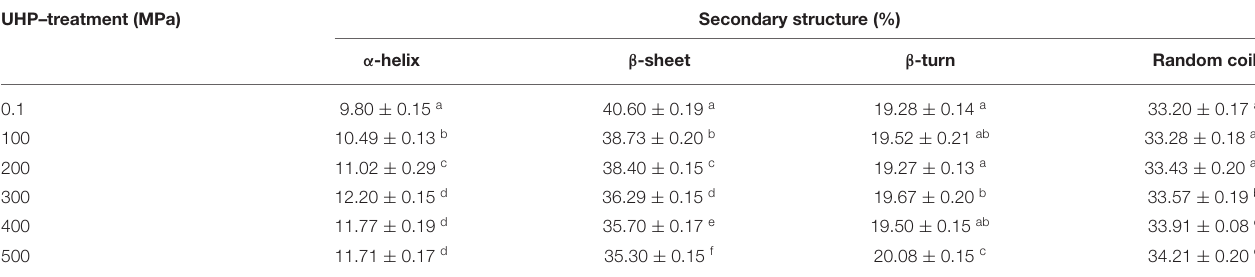
TABLE 1 | Secondary structure contents of myofibrillar protein (MP) from the scallop mantle treated by ultra-high pressure (UHP). UHP–treatment (MPa)